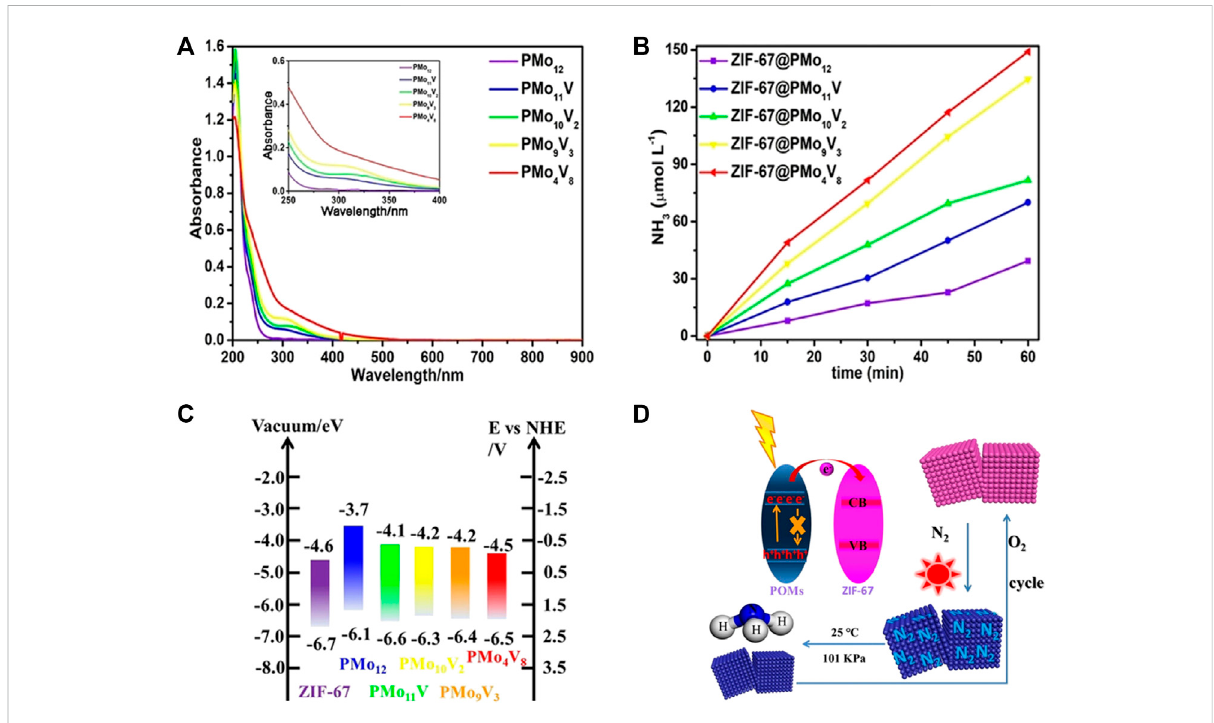
FIGURE 10 (A) UV/Vis absorption spectra of various V-substituted POMs. (B) NH 3 yield as a function of reaction time on various ZIF-67/POMs hybrids. (C) Energy levels and (D) electron-transfer mechanism for ZIF-67/POMs hybrids. Reproduced from Hongda Li et al. (2020) with permission from the John Wiley and